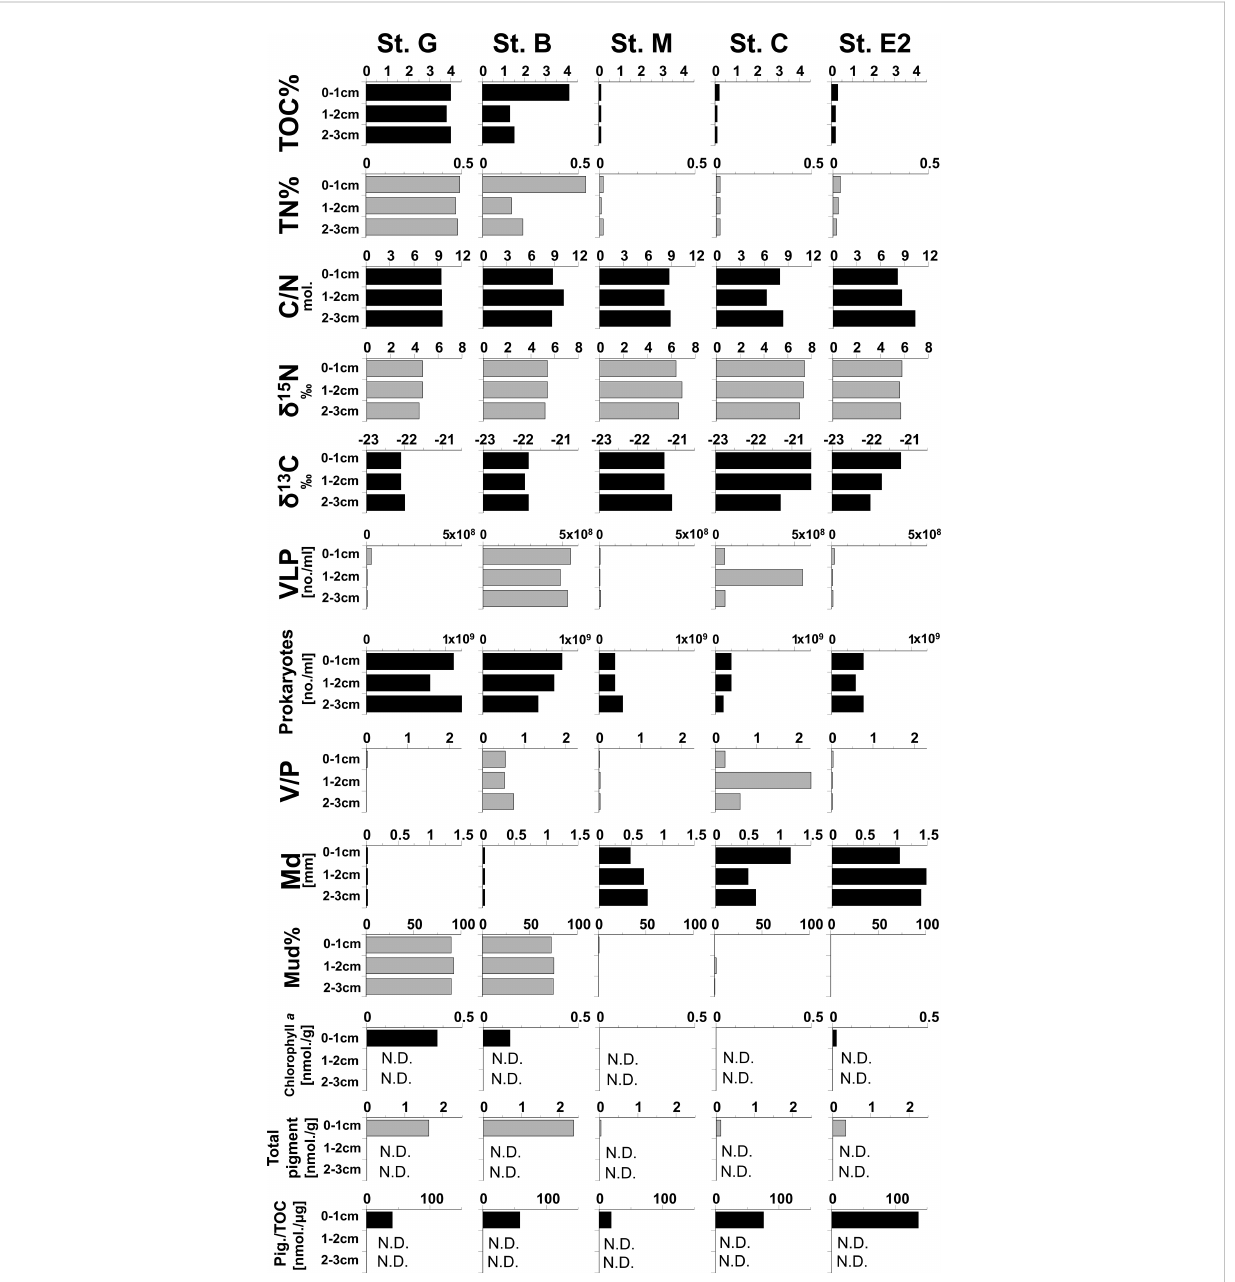
FIGURE 5 Vertical pro fi les of geochemical parameters in sediments at fi ve stations in the southeastern Bering Sea. VLP: Virus-like particles, V/P: ratio of numbers of VLP/Prokaryotes, Total pigments: Chlorophyll a + pheopigments, Pig./TOC: Total pigments per m g of TOC in sediment. The data of these parameters are shown in Table